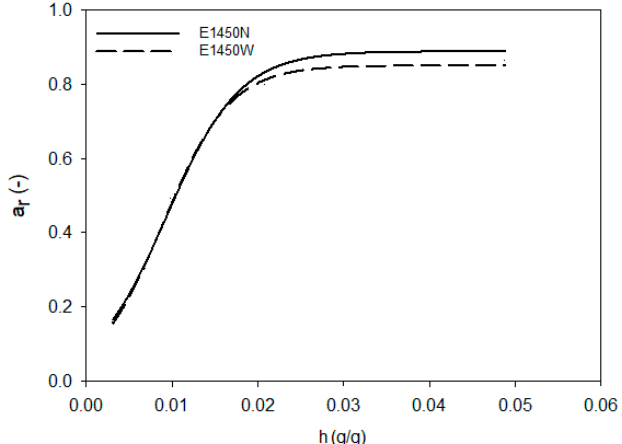
Figure 2. Changes in the equilibrium value of water activity during hydration of OSA starch aerogels.